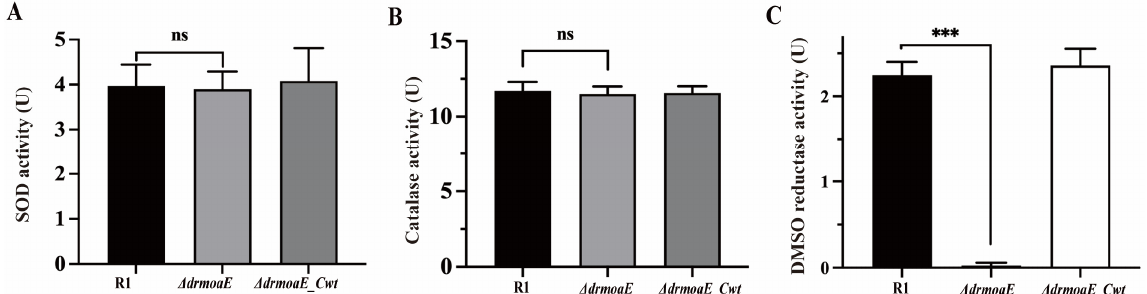
Figure 5. Activities of superoxide dismutase (SOD) (A), catalase (CAT) (B), and DMSO reductase ( C ) in the wild-type strain (R1), the mutant strain ( Δ drmoaE ), and complementary strain ( ∆ drmoaE_Cwt ). Each value represents the mean of three assays (mean ± SD). “ns” means not significant. *** p < 0.001. It has been shown that the activities of some Moco-dependent oxidoreductases, such as DMSO reductase, depend on Moco biosynthesis [24]. The DMSO reductase family found in bacteria and archaea catalyzes oxygen atom transfer and simple redox reactions. The intracellular DMSO reductase activity of the wild-type strain, ∆ drmoaE mutant strain, and ∆ drmoaE_Cwt complementary strain was analyzed, and intracellular DMSO reductase